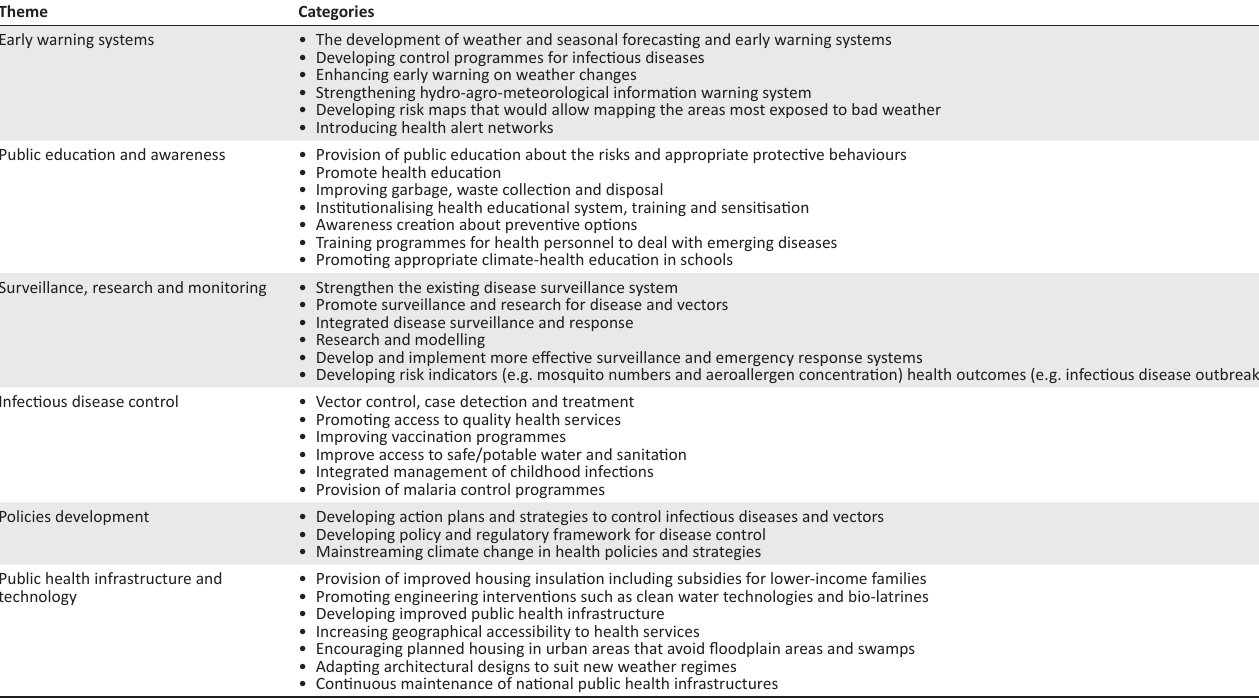
TABLE 2: Emerging themes and categories of the reviewed adaptation